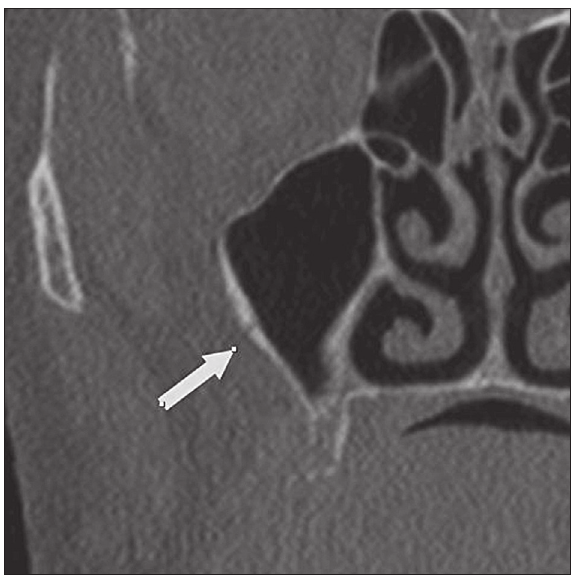
Figure 3 - Coronal view of the maxillary sinus reveals the artery (arrow), which is below the membrane.